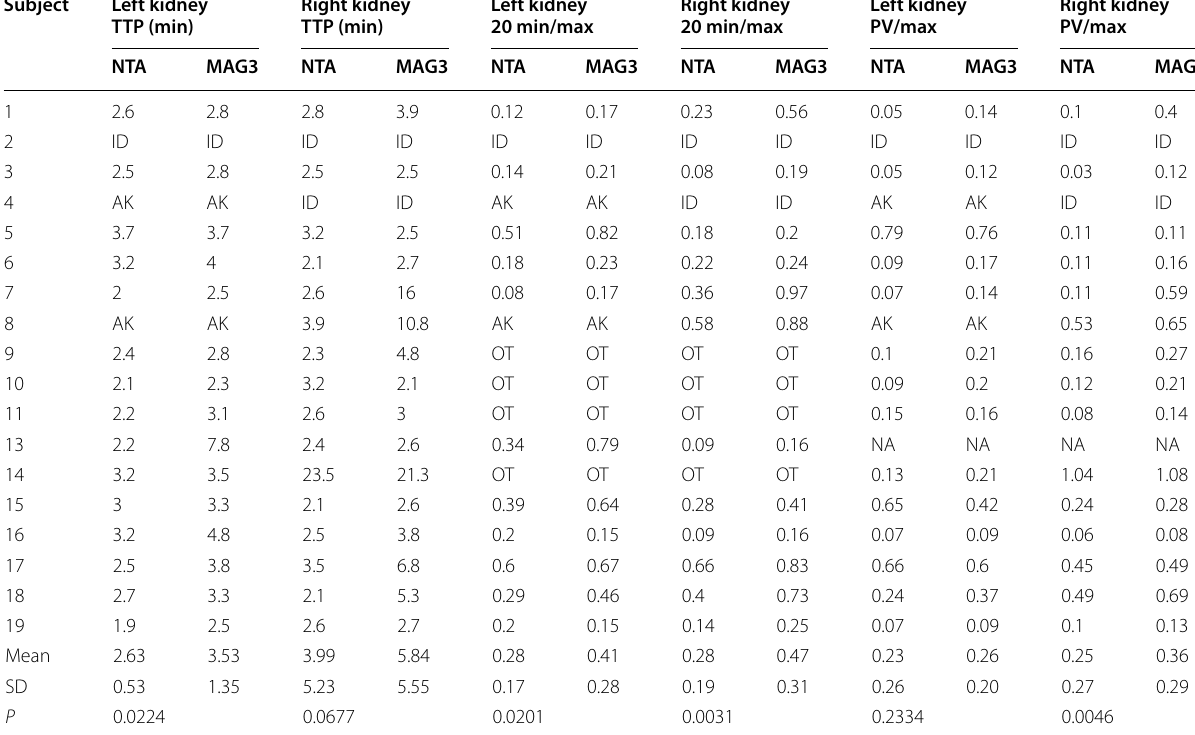
Table 3 Time to peak (min), 20 min/maximum and postvoid/maximum count ratios for the right and left kidneys following administration of NTA and